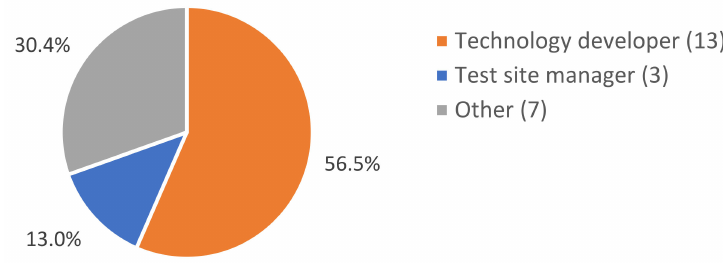
Figure 2. Survey respondents—stakeholder